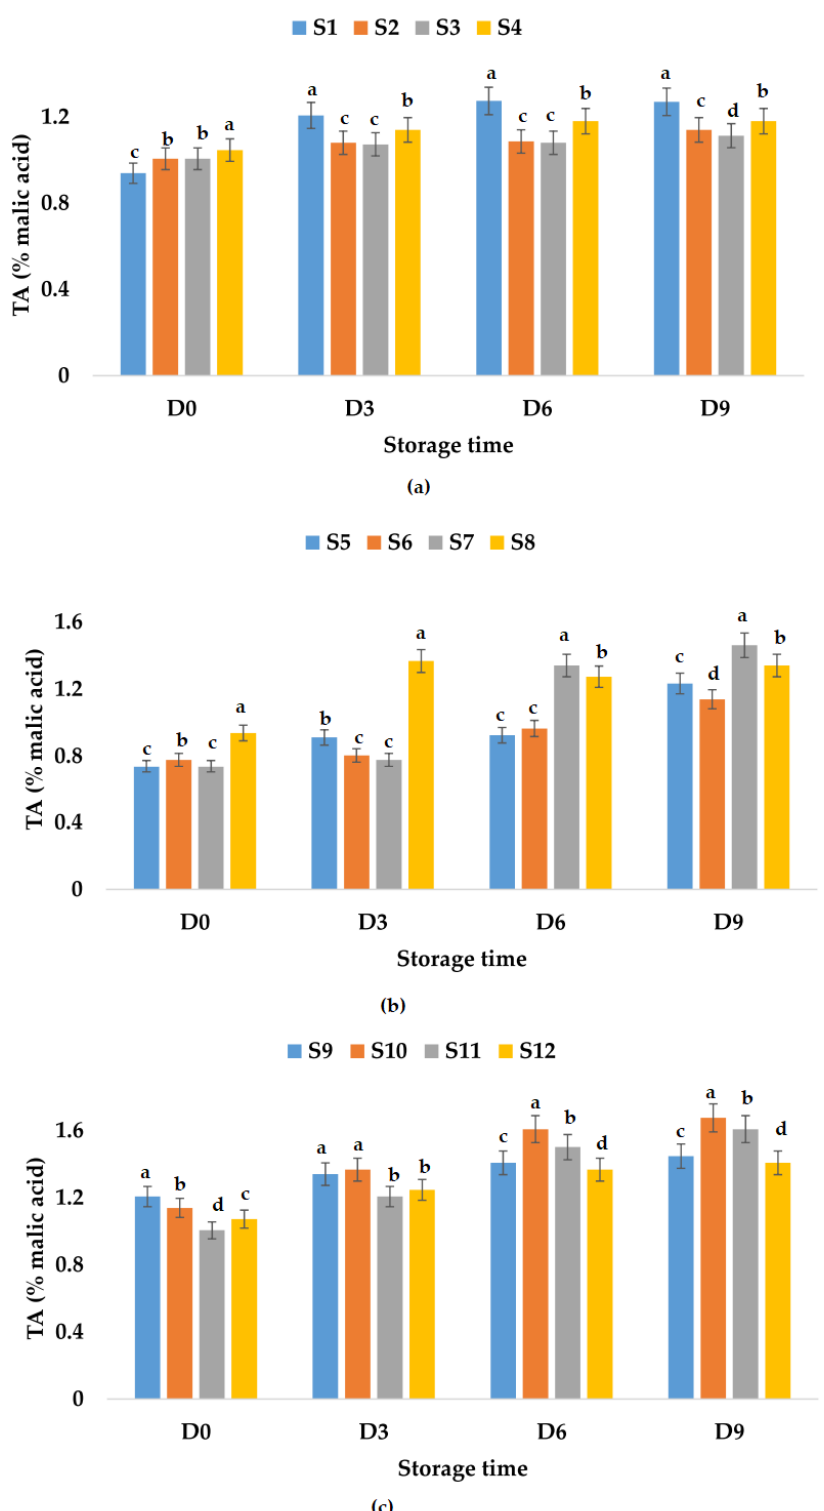
Figure 4. Variation in TA (% malic acid) of juice samples during the storage period (D-day) at room temperature (20 ◦ C): ( a ) apple juice samples (S1, S2, S3, S4); ( b ) apple and pumpkin juice samples (S5, S6, S7, S8); ( c ) apple and pomegranate juice samples (S9, S10, S11, S12). Means with different lowercase letter indicate the significant differences ( p < 0.05) among the samples and were performed separately for each day of